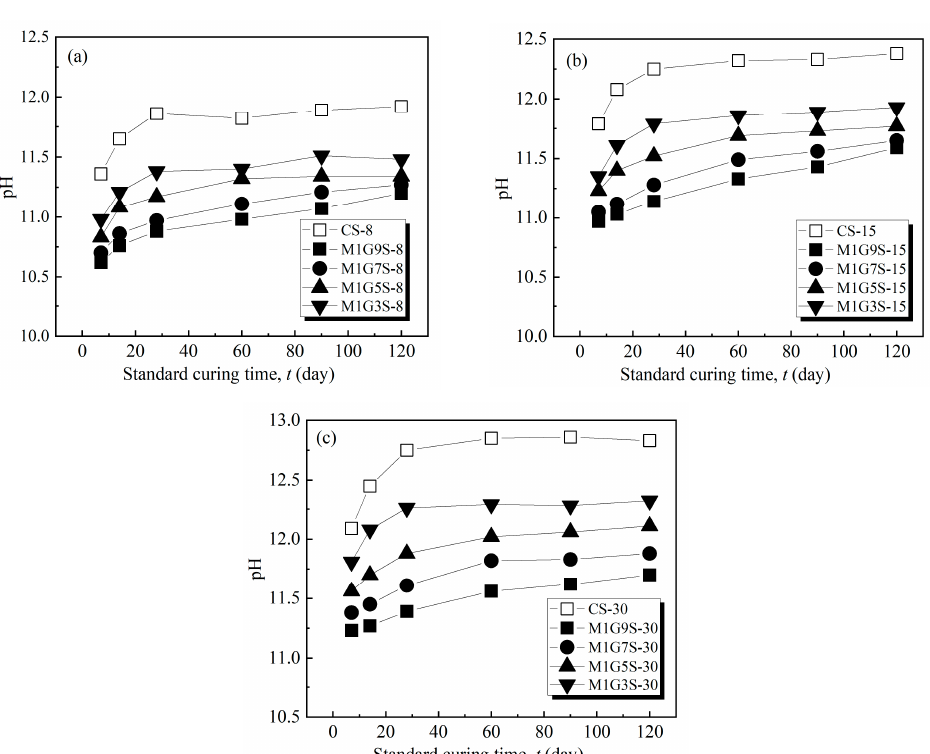
Figure 7. Variations of pH with different ratios of binder on ( a ) 8%, ( b ) 15%, and ( c )